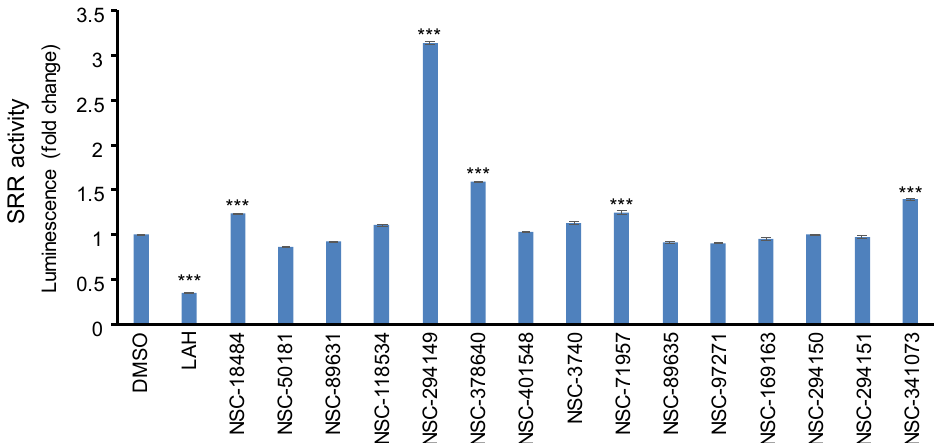
Figure 5. The effect of candidate compounds on SRR activity. DMSO serves as the blank control, while LAH is a positive control of the SRR inhibitor. The error bar is the standard error of the mean (SEM); *** denotes p < 0.0001 for Student’s t ‐ test compared to DMSO control .